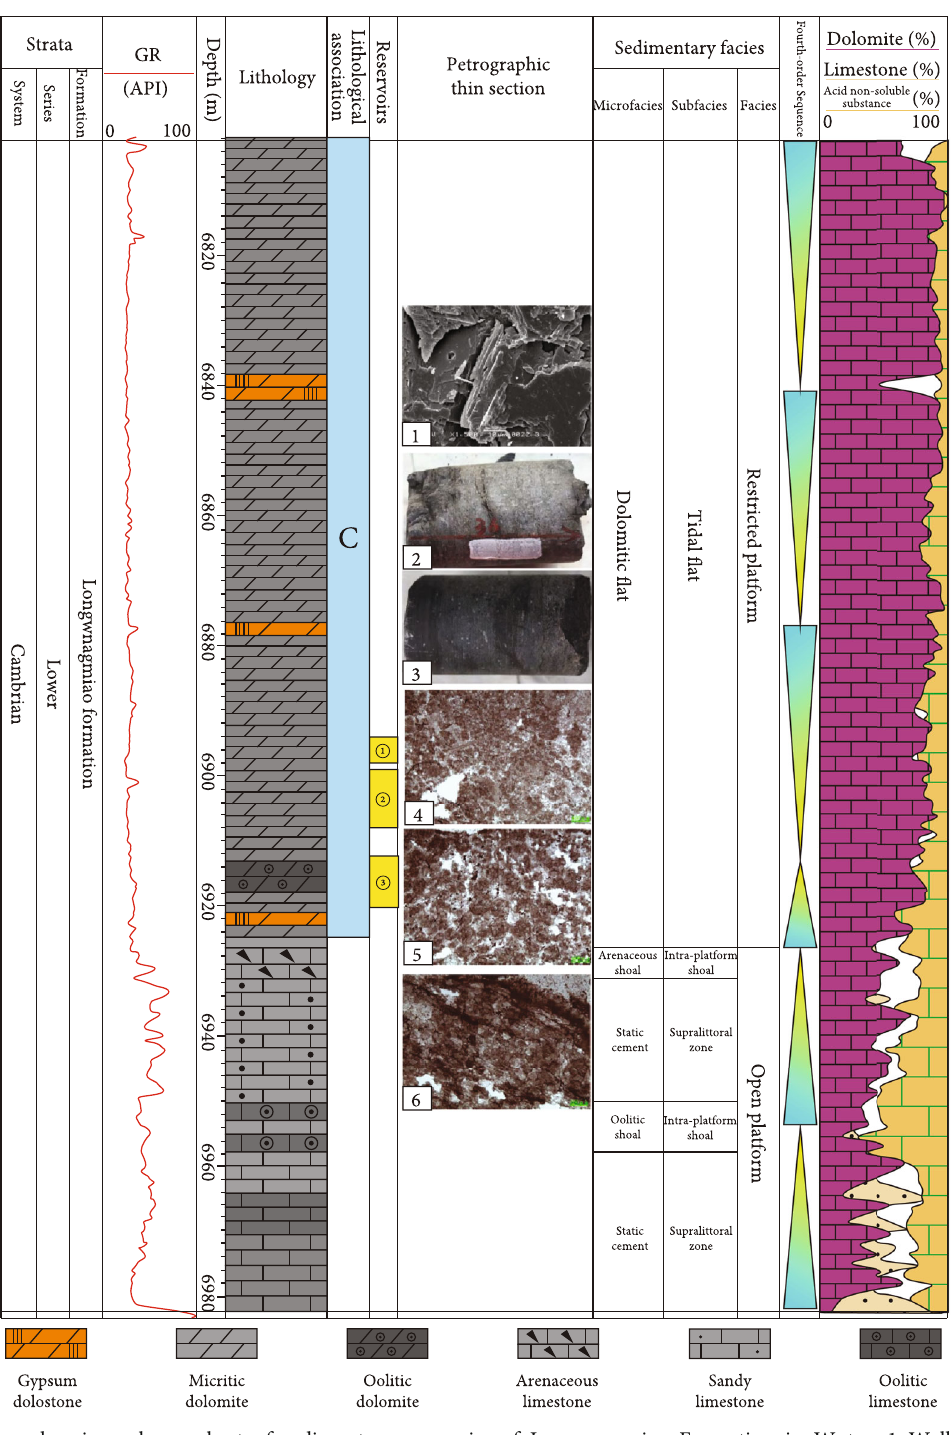
Figure 13: Comprehensive column chart of sedimentary reservoirs of Longwangmiao Formation in Wutan 1 Well, Sichuan Basin. 1.6895.52 m, microcrystalline dolomite, small amount of dolomite intercrystalline micro-hole slit, SEM; 2.6896.76m, grey powder crystal dolomite, few dissolved pores, microcracks; 3.6900m, dark grey powder crystal dolomite, dissolved pores; 4.6907m, fi ne-grained dolomite, residual grains shadows, dissolved pores, quartz crystals, 10 × 5(-); 5.6916m, oolitic dolomite, intergranular and intergranular pores, asphalt impregnation, fi ne-grained structure, 10 × 5(-); 6.6921m, fi ne-grained dolomite, oolitic phantom, crystalline interhole, 10 ×